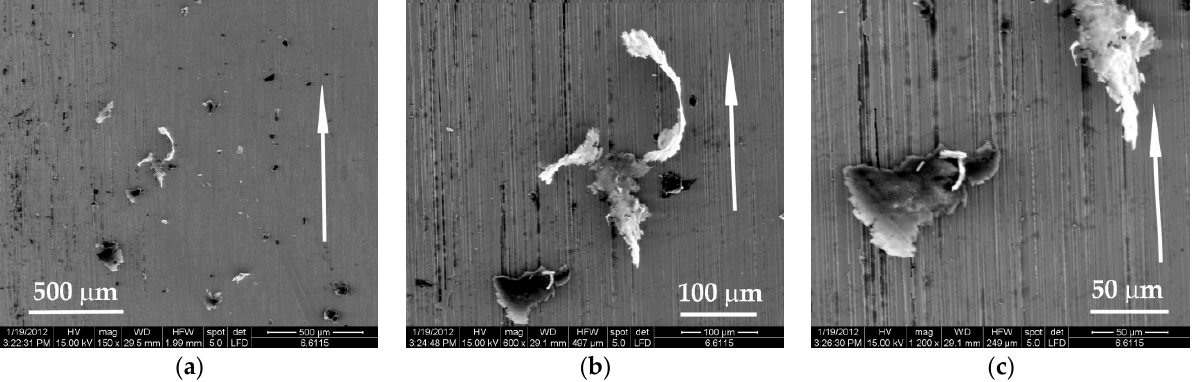
Figure 16. Wear debris from PBT + 15% PTFE blocks on steel counterparts, tested under 5 N, v = 0.25 m/s, L = 7500 m: ( a ) wear debris with different concentrations of PTFE (PTFE is bright white, PBT is gray); ( b ) two different wear particles; ( c ) detail of the particles in the previous image.